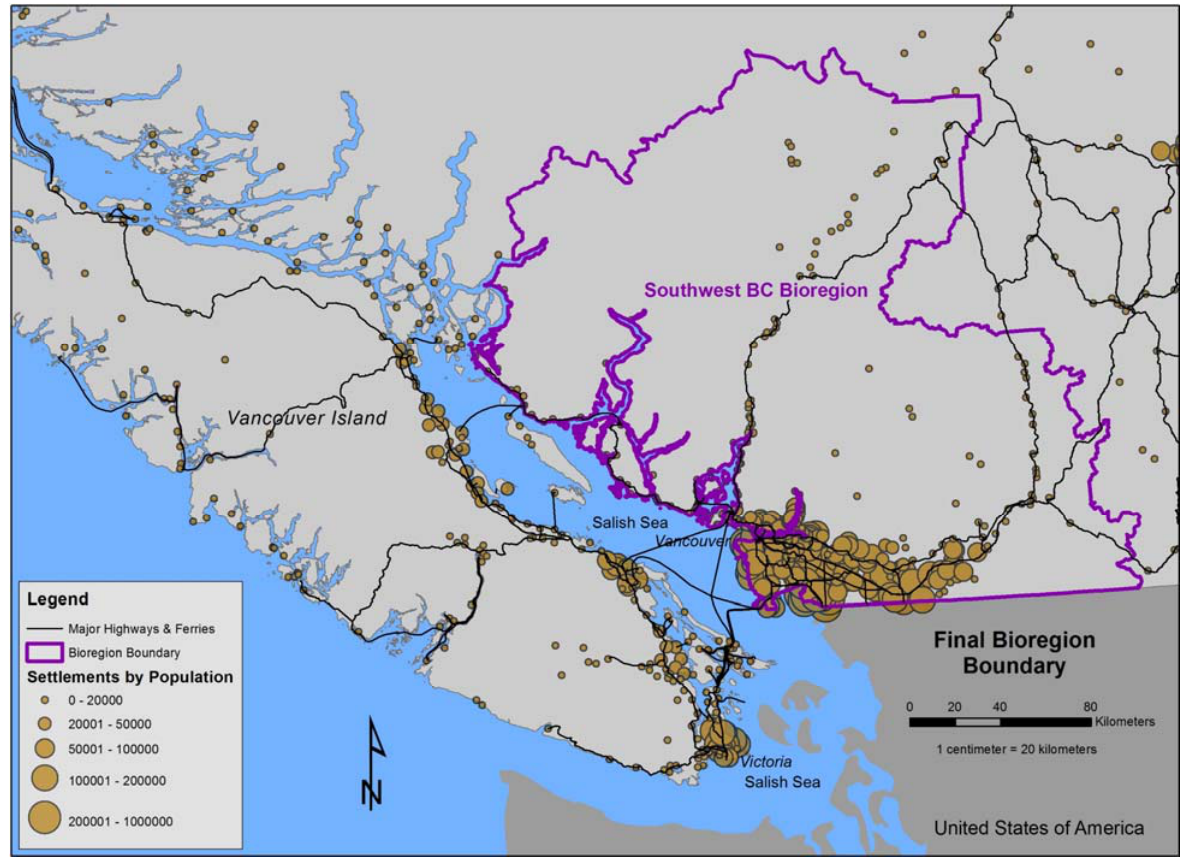
Figure 5. The Southwest British Columbia Bioregion. This shows the final boundary in relation to major settlements and transport